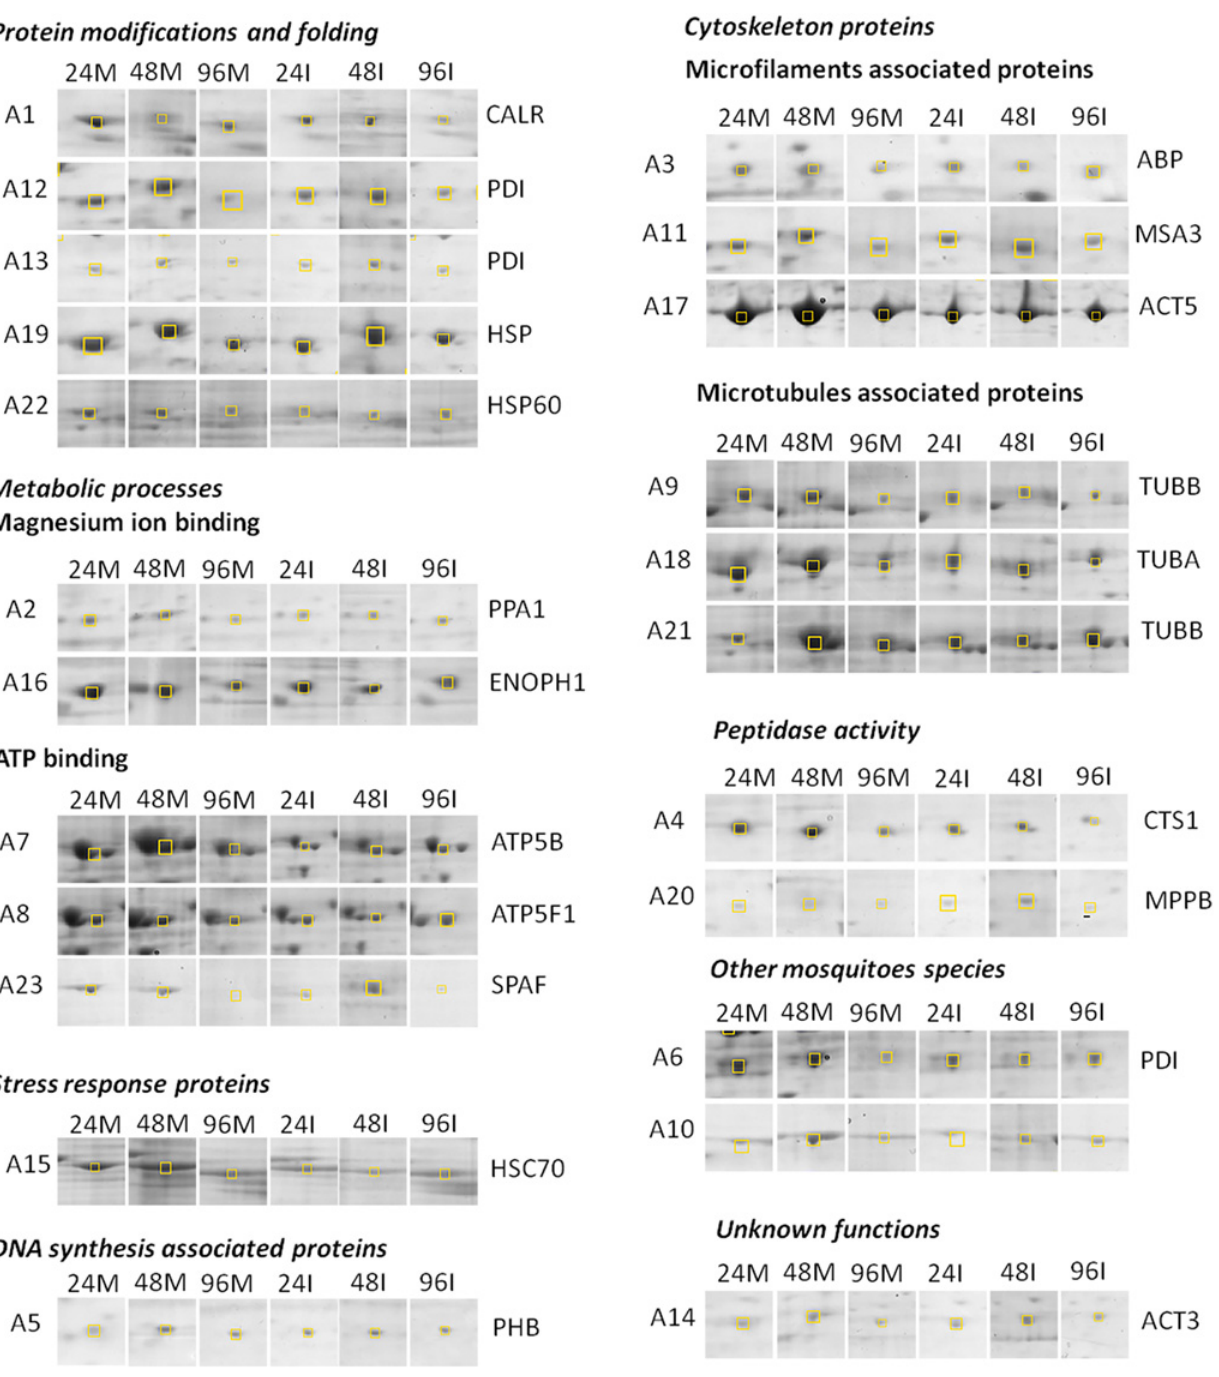
Fig 2. 2-DE dynamic profiles of the selected host proteins upon CHIKV-infection at M.O.I. 10. Yellow box indicates the differentially expressed proteins. Mock-infection for each time-point served as a control, as shown in panel 24M, 48M and 96M. CHIKV-infection profiles analyzed at 24, 48 and 96 h.p.i., as shown in the panel of 24I, 48I and 96I, respectively. The functional grouping of each protein is shown in UniprotKB database.